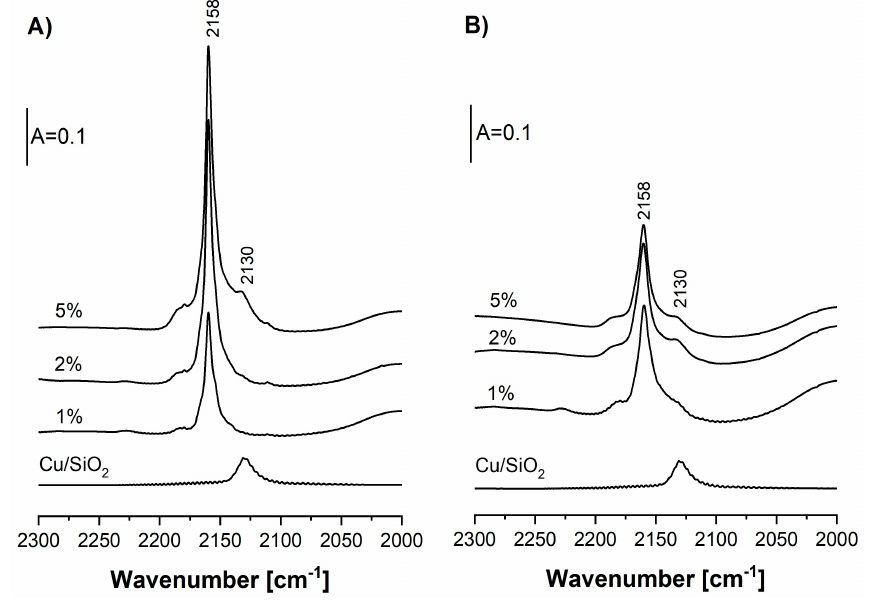
Figure 3. IR spectra of CO interacting at room temperatures with Cu sites in zeolites CuHFAU ( A ) and CuNaFAU ( B ) of various Cu contents. The amounts of CO were sufficient to cover all the Cu sites. The spectra of CO interacting with Cu in Cu/SiO 2 are also shown.